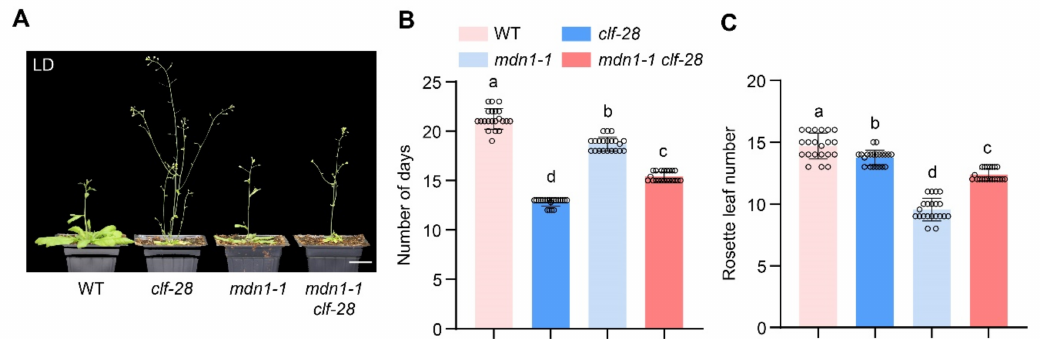
Figure 5. clf-28 accelerates the early flowering of mdn1-1 . ( A ) clf-28 , mdn1-1 and mdn1-1 clf-28 grown in LD. ( B , C ) The number of days and rosette leaf number at the flowering in LD. Twenty plants per line were scored. One-way ANOVA was employed, and the lowercase letters denote distinct groups ( p < 0.01). Scale bars, 2